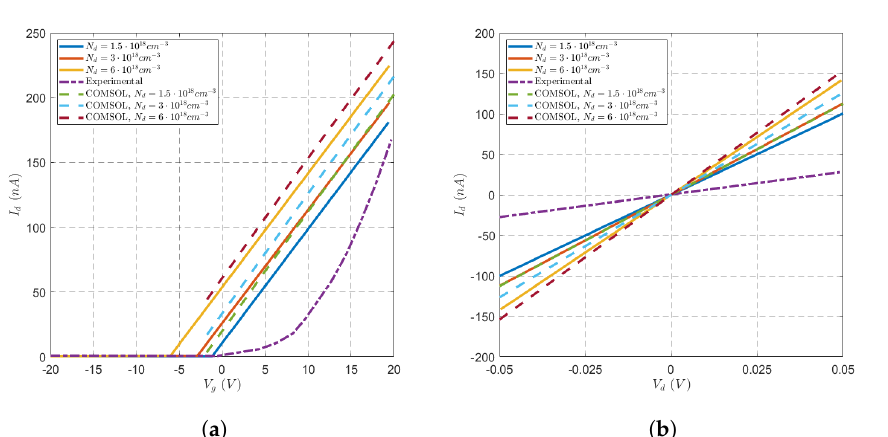
Figure 7. I-V curves for monolayer MoS 2 . Transfer characteristic for different doping concentration and V ds = 0.01 V ( a ), output characteristic for V gs = 10 V ( b ).